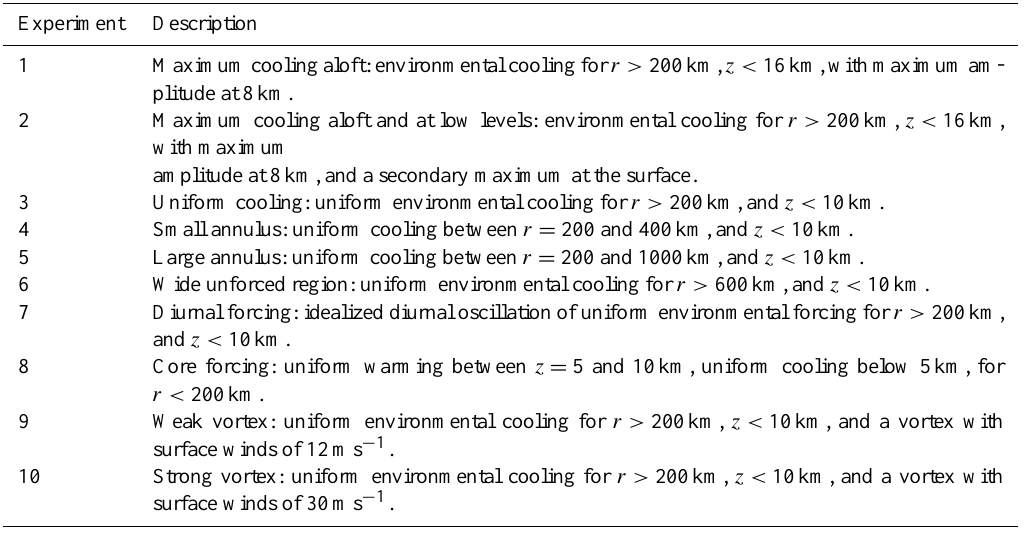
Table 2. Experiments with prescribed thermal